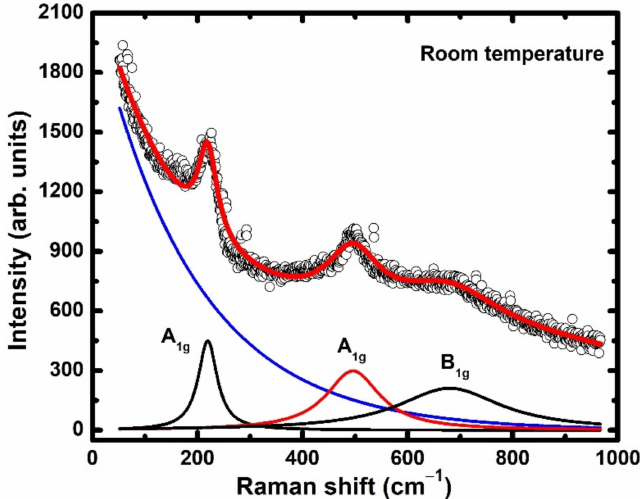
Figure 7. Raman spectrum measured at room temperature in the frequency range of 50–980 cm − 1 . The total fitted and individual components of the spectrum are also shown